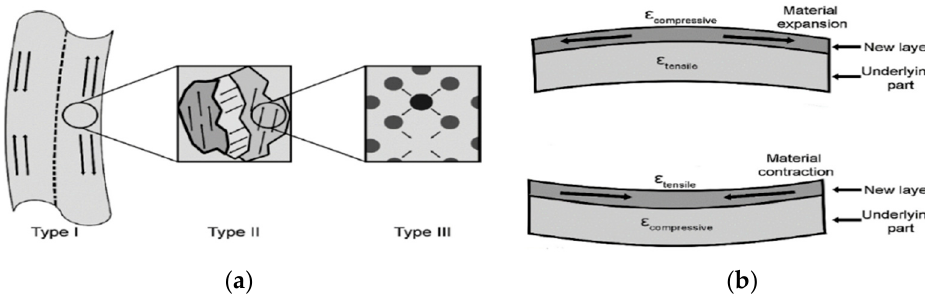
Figure 3. ( a ) Residual stresses classification and ( b ) plastic deformation development. Reproduced from [36], with permission of Elsevier, 1996.